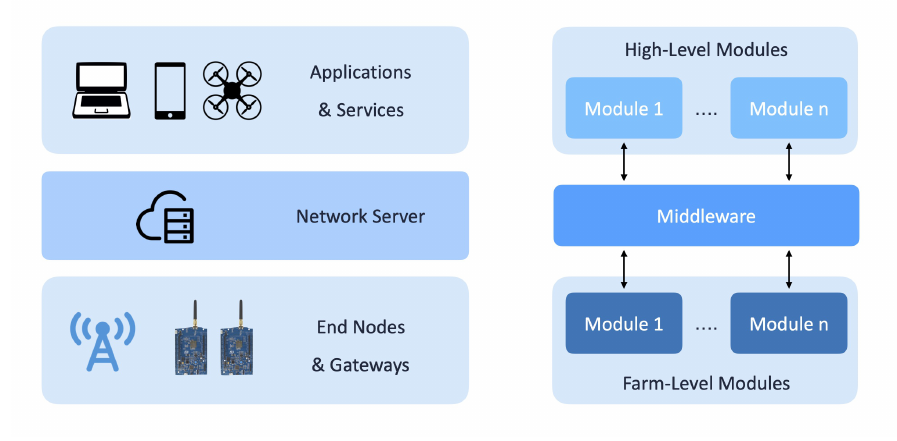
Figure 2. LoRaFarM platform: level decomposition and parallelism with LoRaWAN architectural